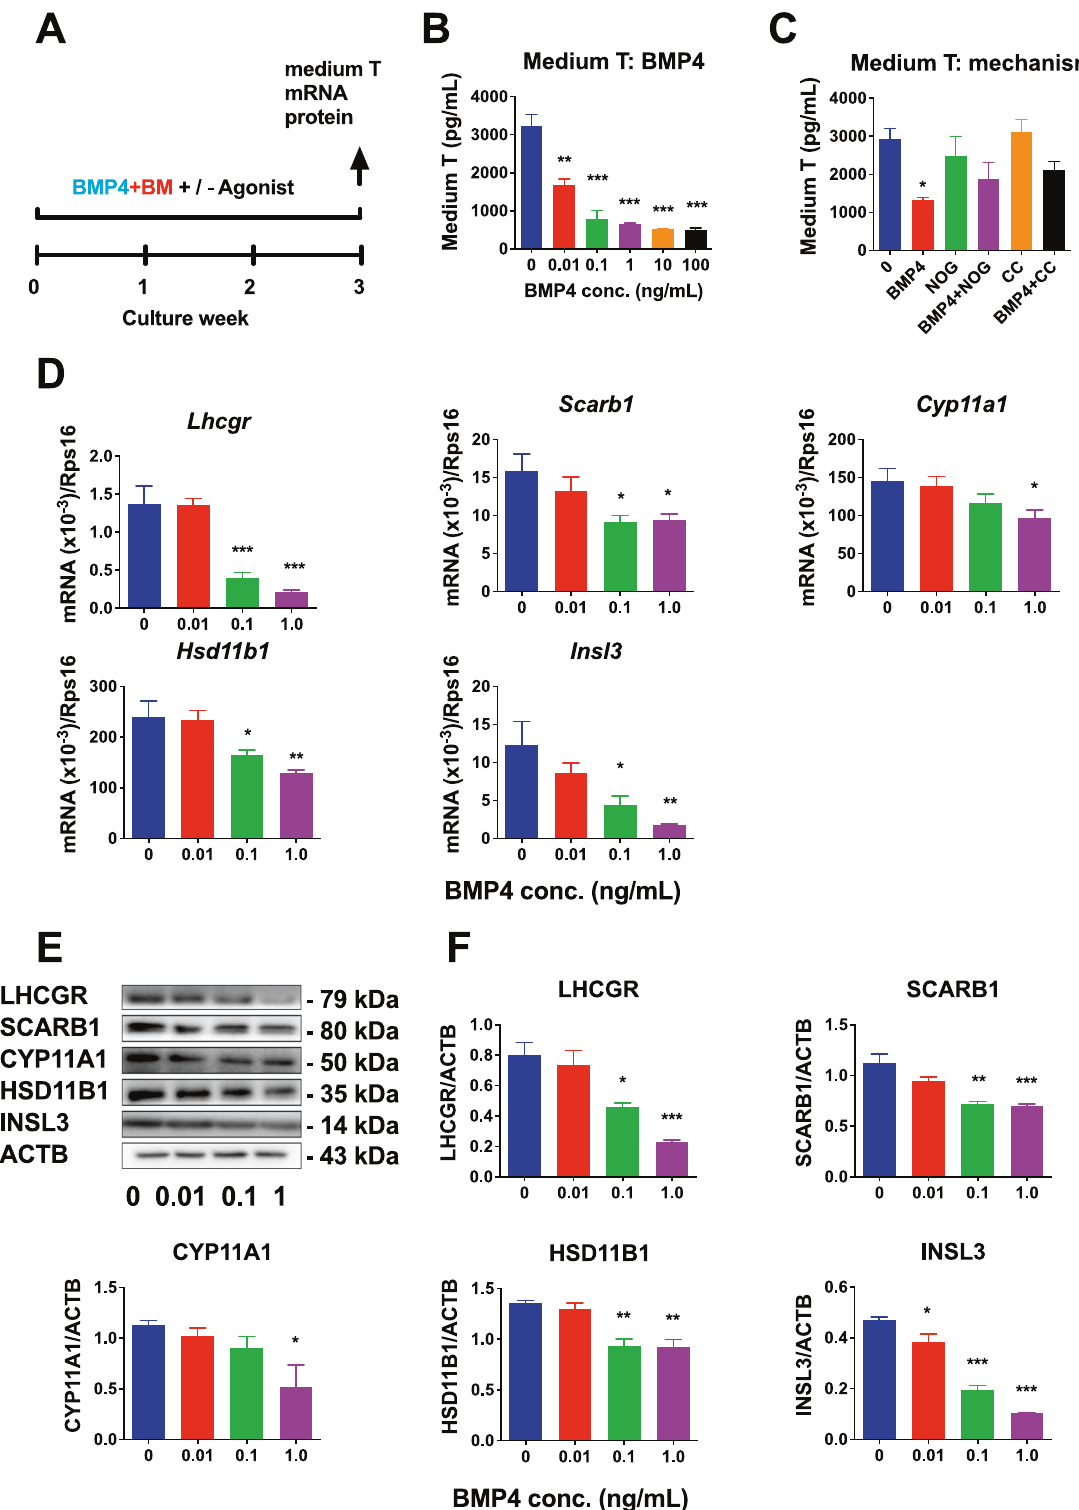
Fig. 5 Effects of BMP4 on stem Leydig cell (SLC) differentiation in vitro. A Seminiferous tubule (ST) culture protocol. B Medium testosterone (T) levels after BMP4 treatment; Mean ± SEM, n = 6; C Medium T with 1 ng/mL BMP4 with or without NOG (1 ng/mL) or CC (5 ng/mL). Mean ± SEM, n = 5; D Lhcgr, Scarb1, Cyp11a1, Hsd11b1 , and Insl3 mRNA levels in STs treated with BMP4 for 3 weeks by qPCR and normalized to Rps16 ; Mean±SEM, n = 6. E Western blot. F Protein levels of LHCGR, SCARB1, CYP11A1, HSD11B1, and INSL3 in STs treated with BMP4 and normalized to ACTB; Mean ± SEM, n = 3. * P < 0.05, ** P < 0.01, and *** P < 0.001 indicate signi fi cant differences compared to control (0 ng/ mL BMP4).